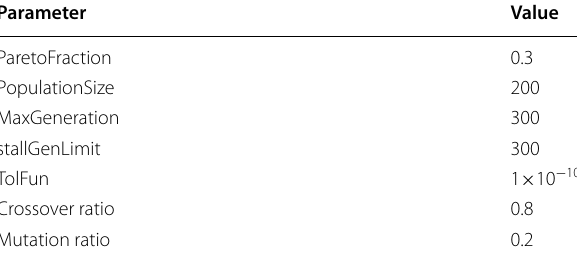
Table 8 Genetic algorithm parameter settings